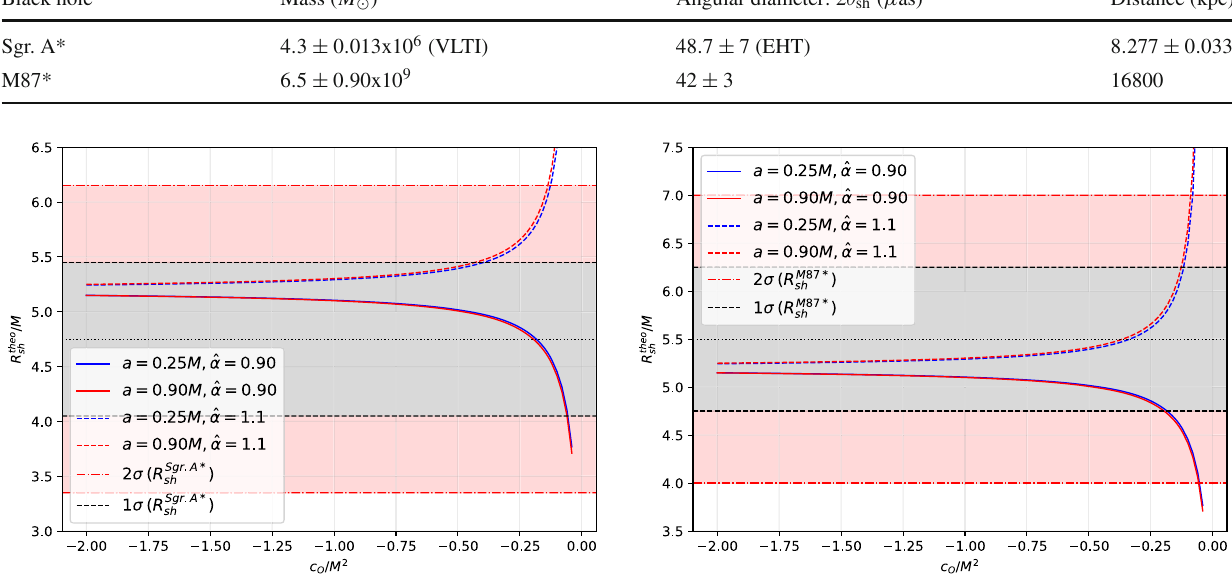
Fig. 5 Constraint on the symmergent gravity parameter c O by the Sgr. A* data (left-panel) and M87* data